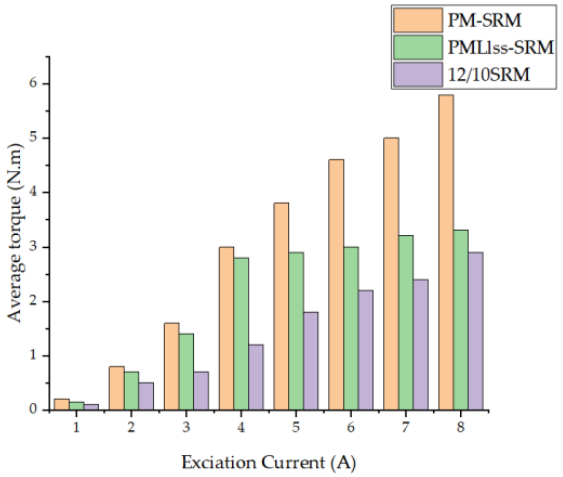
Figure 7. The new external rotor multi-teeth permanent magnet SRM [31].